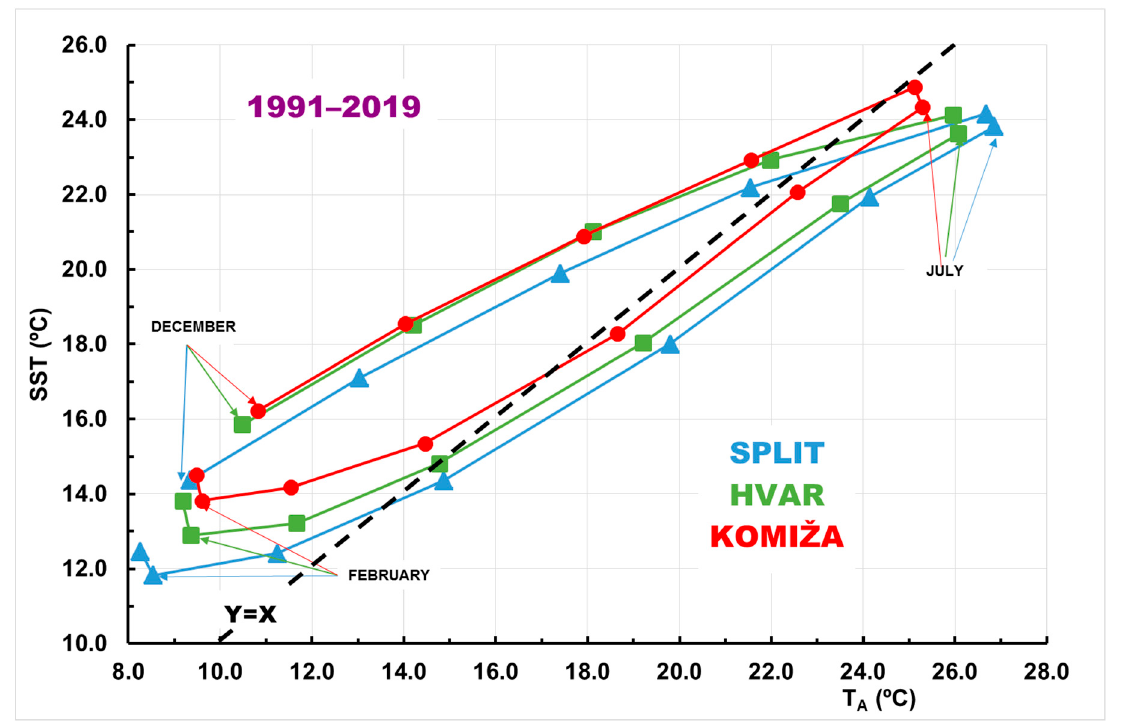
Figure 8. The ratio of the mean monthly SST and air temperature from the period of contemporaneous measurements at all three analyzed stations.